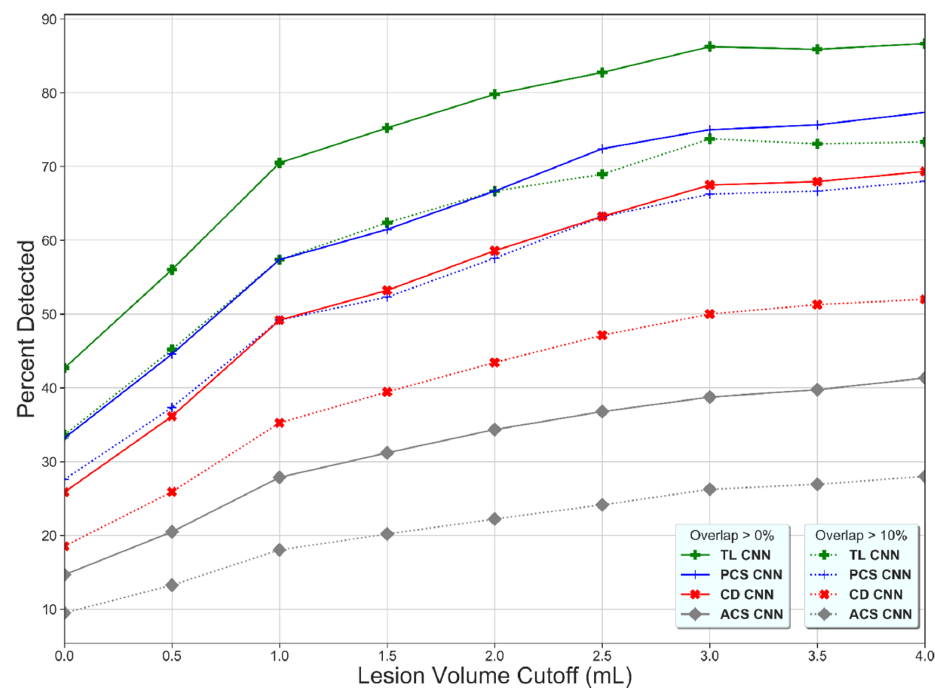
Figure 2. Percentage of detected lesions ( y -axis) as a function of the minimum volume requirement ( x -axis) and the minimum percentage of overlapping voxels for the Transfer Learned CNN (TL-CNN), Posterior Circulation Stroke CNN (PCS-CNN), Combined Datasets CNN (CD-CNN), and Anterior Circulation Stroke CNN (ACS-CNN) (green, blue, red, and gray lines). For all methods, a higher lesion volume cutoff results in a higher percentage of detected lesions. The lower overlapping voxel requirement, the higher the percentage of detected lesions (dotted versus solid lines). The TL-CNN, PCS-CNN, CD-CNN, and ACS-CNN achieved a Dice coefficient of